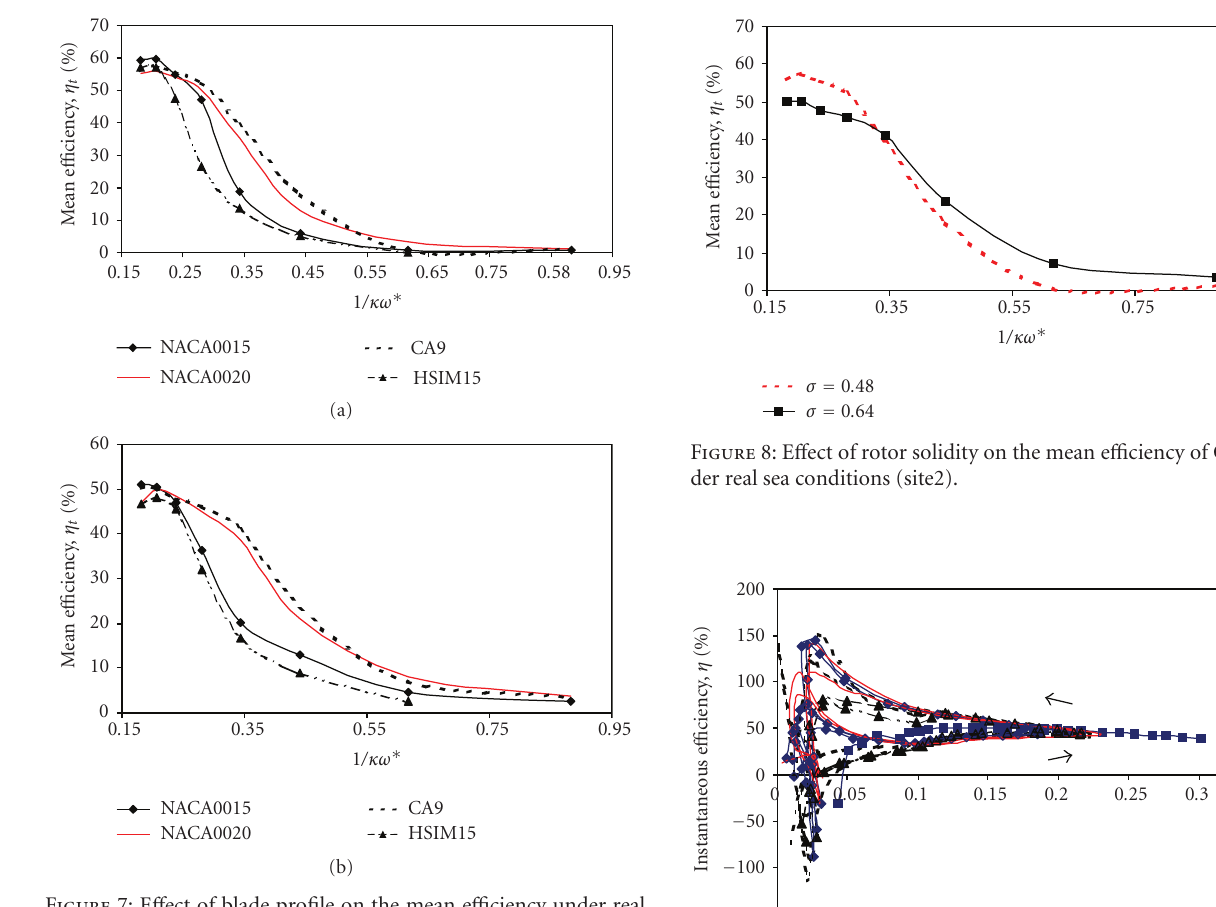
Figure 7: E ff ect of blade profile on the mean e ffi ciency under real sea conditions (site2): (a) σ = 0.48, (b) σ = 0.64.